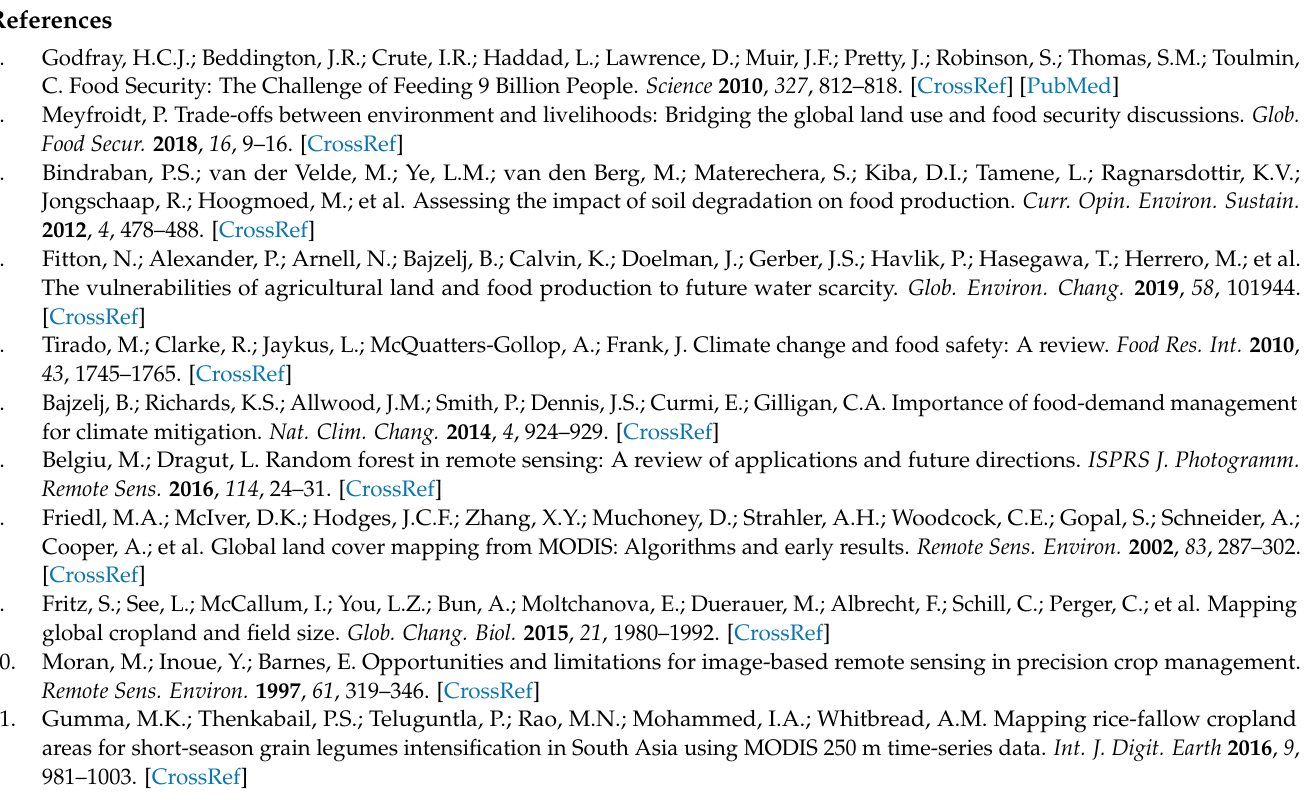
EU countries for 2018. Figure S2: Feature importance values for the tope of 50 variables from random forest models in 2018 (a) and 2019 (b). Figure S3: Visual comparison between our final crop maps (a1–a8) and existing reference datasets in 2018 for France (b1–b6) and Netherlands (b7,b8). For France, winter and spring Triticeae crops was concluded as a single category (green color). Figure S4: Distribution of crop area along latitude gradients (a–d) and longitude gradients (e–h). Figure S5: Temporal profiles of NDVI for maize of different countries. Lines depicts the mean values. Shaded area depicts error bars with one positive/negative standard deviation of maize. Table S1: The number of Sentinel-2 images processed in this study for each country in 2018 and 2019. Table S2: Confusion matrix of the point-based validation for England in 2019. Table S3: Confusion matrix of the point- based validation for England in 2018. Table S4: Confusion matrix of the point-based validation for Netherlands in 2019. Table S5: Confusion matrix of the point-based validation for Netherlands in 2018. Table S6: Confusion matrix of the point-based validation for France in 2019. Table S7: Confusion matrix of the point-based validation for France in 2018. Table S8: Confusion matrix of the point-based validation for the whole study area using LUCAS data in